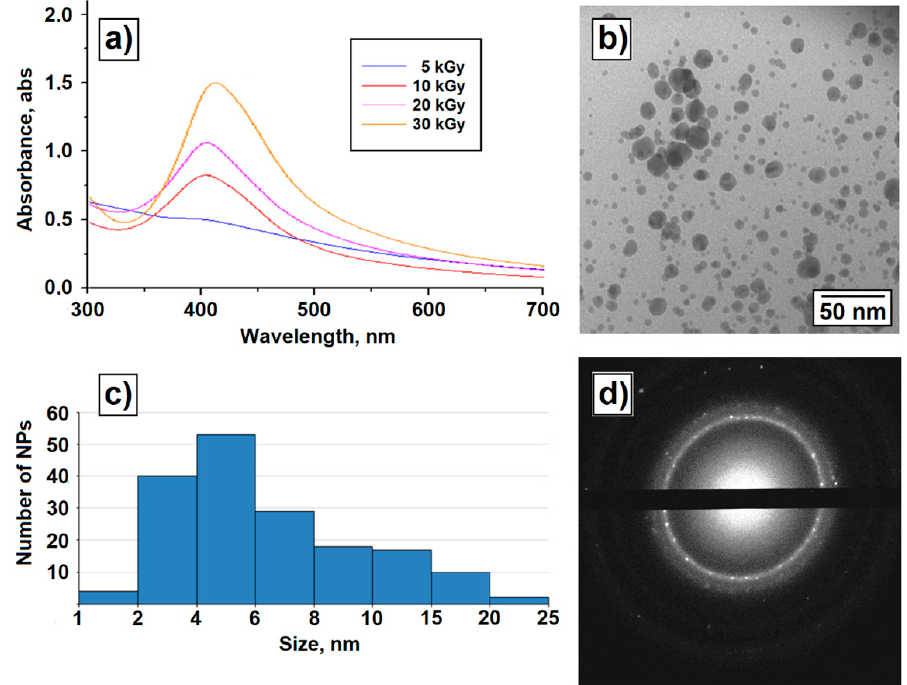
Figure 3. UV–visible spectra ( a ), micrography ( b ), histogram of the size distribution of nanoparticles ( c ), microdiffraction image ( d ) of irradiated PAA–PEI-Ag + complexes, the molar ratio of PAA/PEI units equal to 1/3.